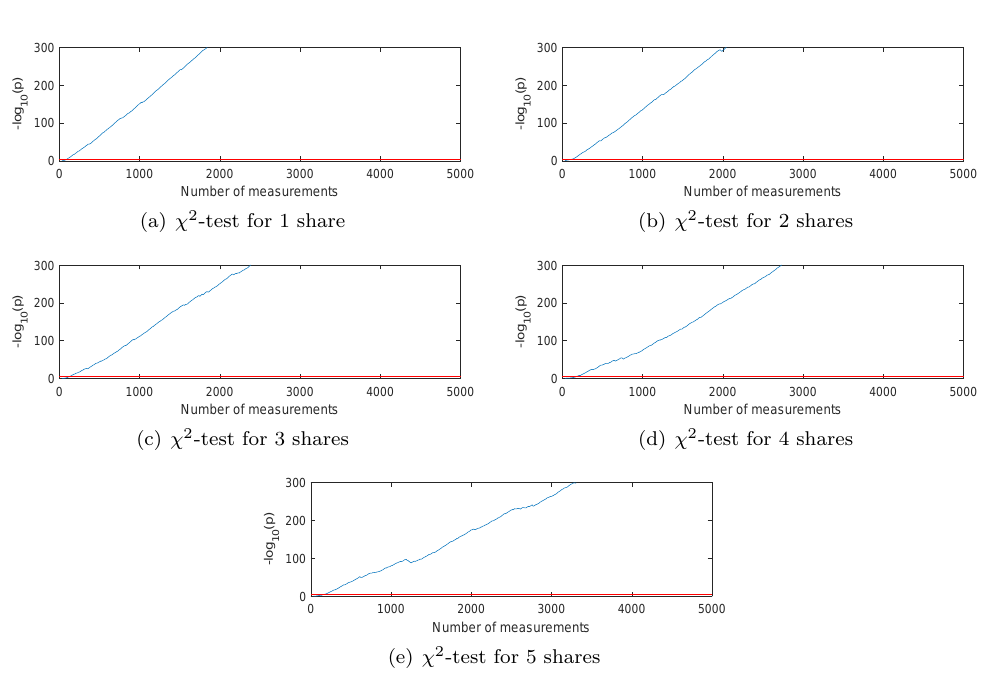
Figure 21: Same experiments as in Figure 11, but without stopping the clock and instead running an LFSR-based PRNG during the measurements.